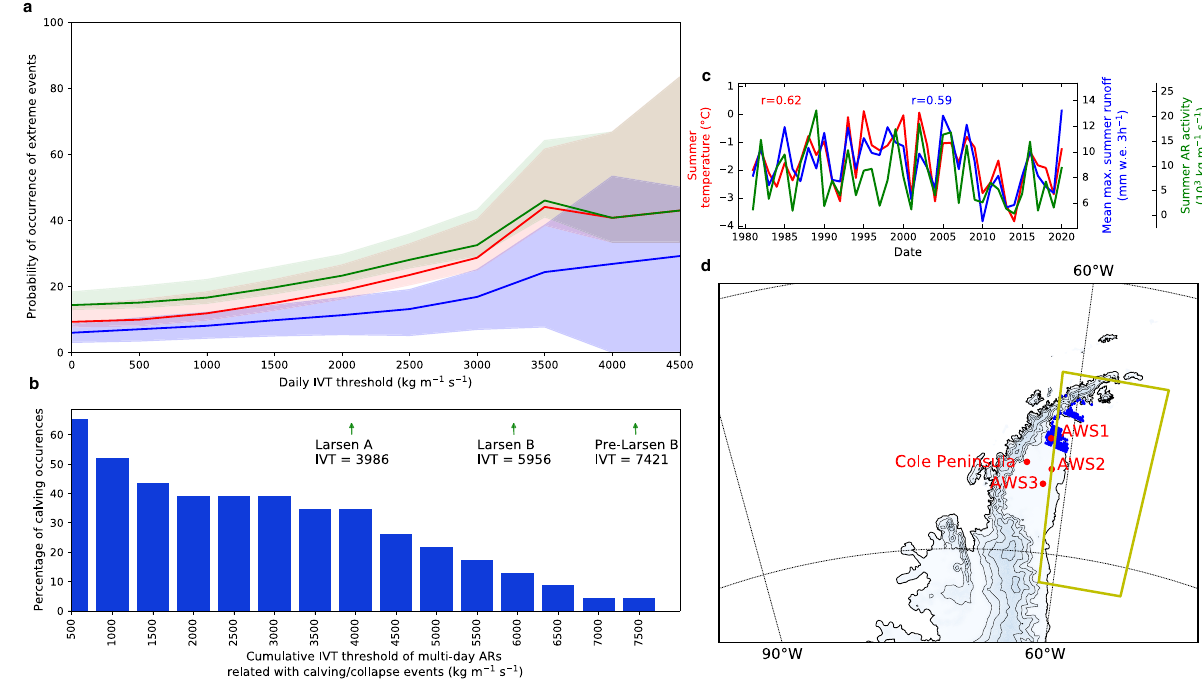
Fig. 6 Percentage of occurrence of extreme events according to IVT threshold. a Probability of occurrence of a daily temperature, melt or runoff value exceeding the 95% percentile Novermber-March) values (blue line and area) at one location of the area highlighted by the blue dots in d which are located below 200 m asl and over the ice mask of the MAR. The line is the mean occurrence for all the points, and the area is the lowest and highest percentages of occurrence (i.e., the 5-95% interval) considering occurrences at each individual point. The red line and area consider the same parameters as the blue line and area, but also includes the occurrence of 2-day sea-ice removal exceeding 2% (SIC > 0.02) in the region described in yellow box. SIC = 0.02 represents the 1 sigma value of all the daily SIC variations observed over 40 years. The green line and area consider the same parameters as the red line, but also includes the occurrence of swell above the 85th percentile (1980 – 2019) within the yellow box in d . b The histogram represents the % of occurrence collapse/calving occurring within 5 days after an AR event as a function of a IVT threshold based on the cumulative values of each continuous multi-day event. This includes 13 calving events plus the Larsen A collapse on January 25, 1995, and the winter calving event of the Larsen C during July 10 – 12, 2017. The pre-Larsen B refers a large calving event occurring on January 6, 2002, and the Larsen B collapse refers to the fi nal collapse after March 2, 2002. c Time series and correlations between cumulative summer (December, January, and February) maximum IVT values during AR landfalls (green), mean summer temperature (red) and mean maximum runoff (blue) over the area highlighted by the blue dots in d